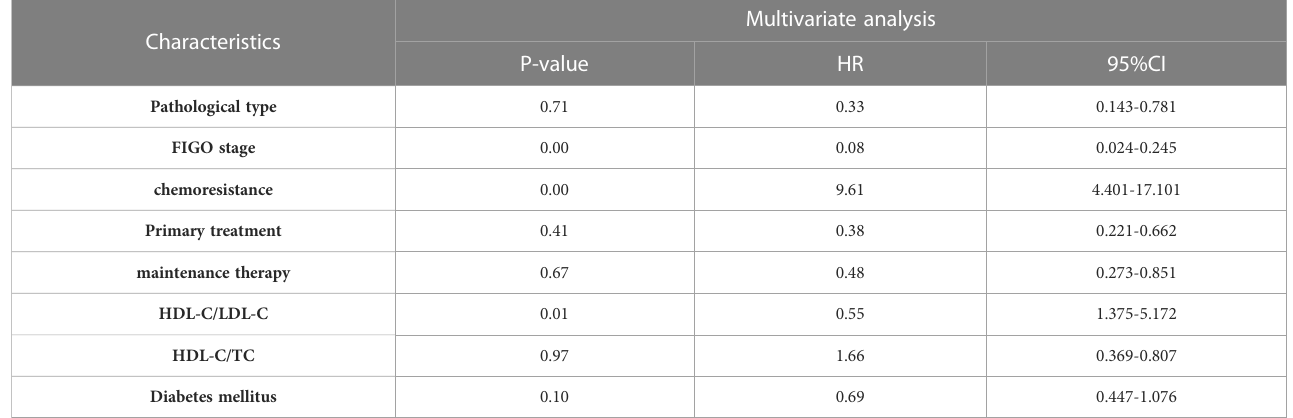
(PFS) and overall survival (OS) in patients with ovarian cancer. FIGO stage and chemoresistance were independent risk factors for FPS and OS. HDL-C/LDL-C ratio and post-operative maintenance therapy were independent protective factors for FPS. HDL-C/LDL-C ratio was